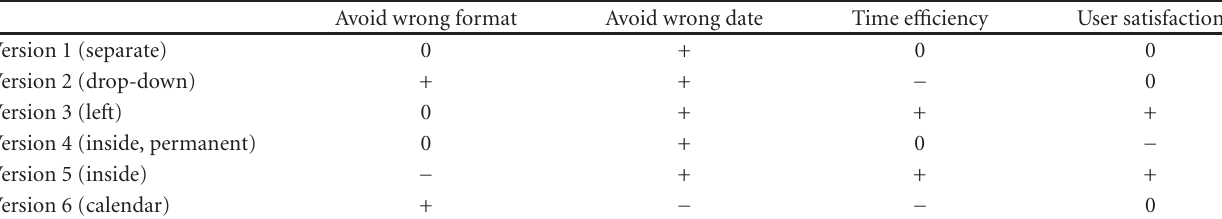
Table 4: Performance overview of the six